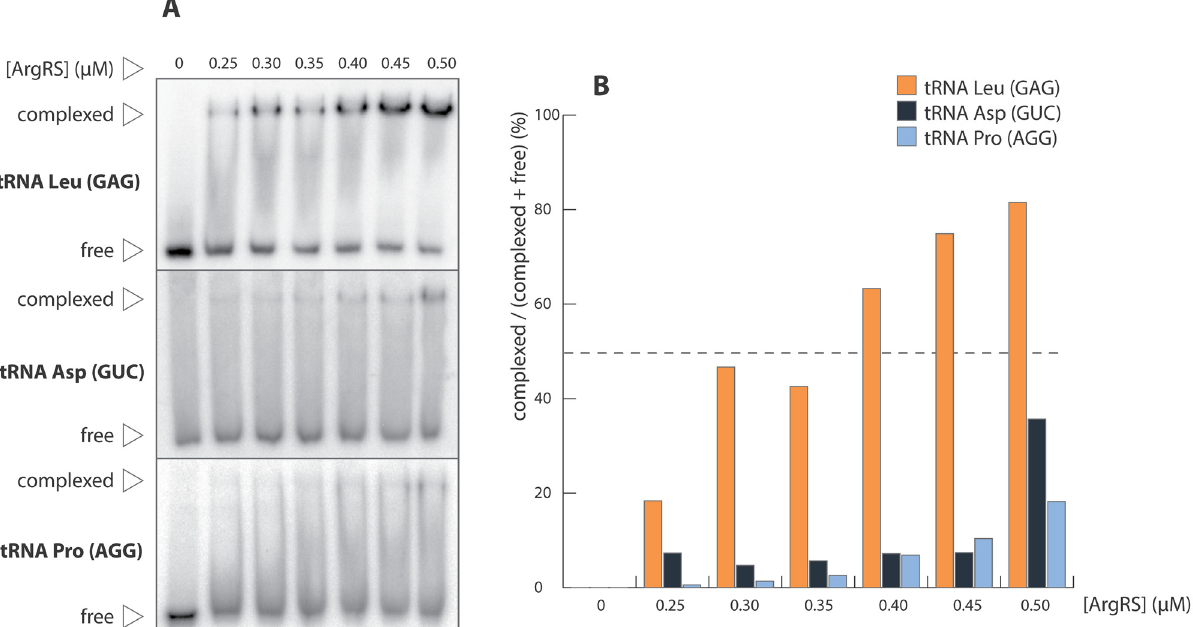
Fig 5. Complexation of yArgRS with isolated tRNAs. (A) Radiolabeled, in vitro transcribed, tRNA Leu (GAG), Asp (GUC) and Pro (AGG) displaying respectively high, medium and low apparent affinities under competition were tested individually in the presence of various concentrations of yArgRS ranging from 0.25 to 0.50 μ M on non-denaturing PAGE. (B) Fractions of complexed tRNA at different enzyme concentrations. The color code corresponds to the relative abundance of each tRNA species at 0.8 μ M (Fig 4, first column).